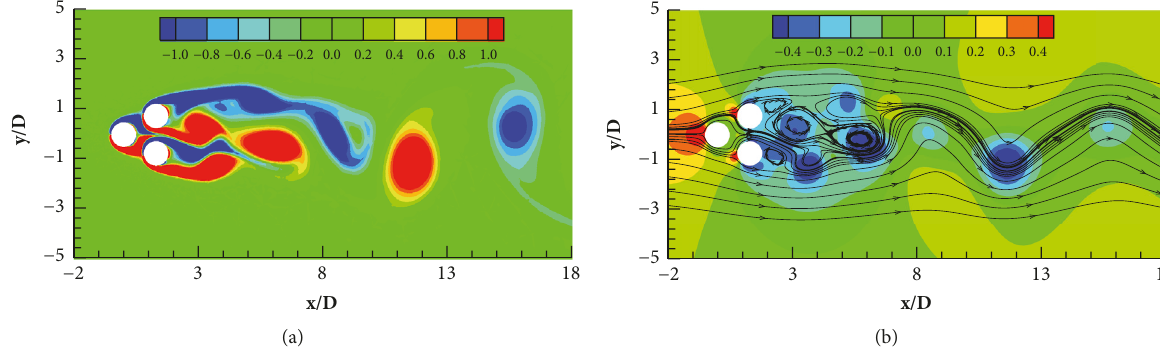
Figure 14: Snapshots of instantaneous flow fields at 𝑆/𝐷 = 1.5 with Re = 200: (a) vorticity contours and (b) pressure contours and streamlines.